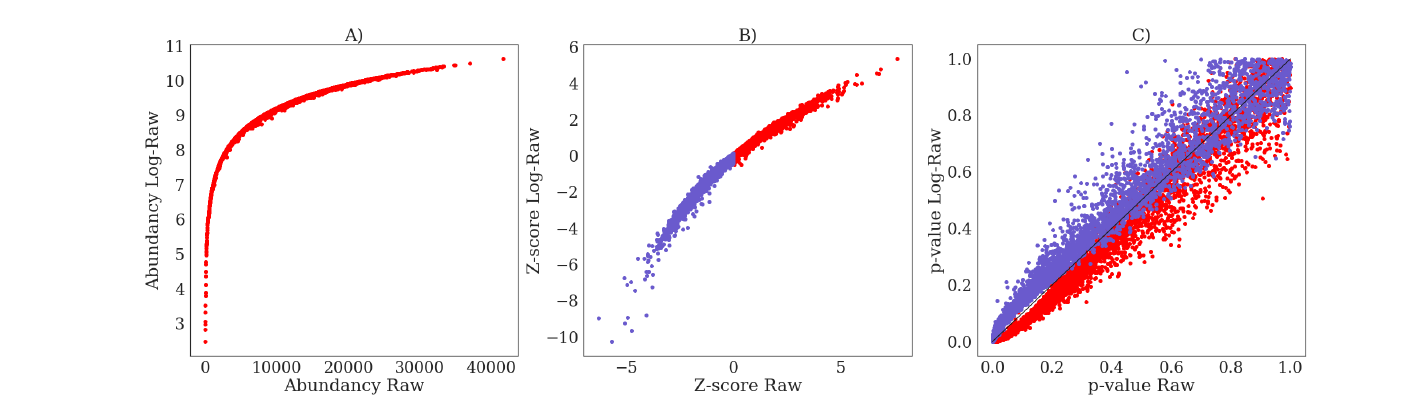
Figure A7. ( A ) The simulated log-transformed abundancies ( Log-Raw ) versus the raw abundancies ( Raw ). ( B ) The difference in Z-scores between Log-Raw and Raw . ( C ) The difference in Welch’s t -test p -values between Log-Raw and Raw